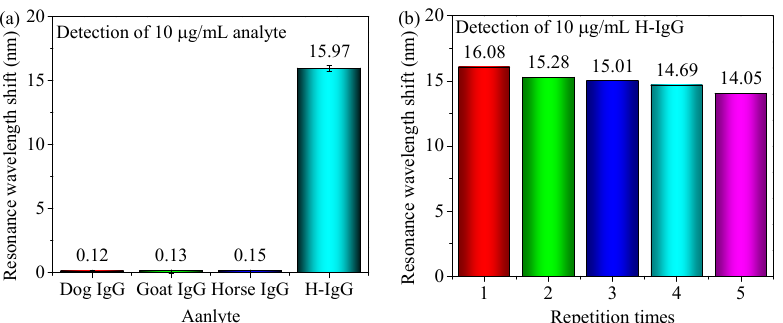
Figure 8. The ( a ) specificity and ( b ) repeatability of the sensor. Error bar = ± S.D., and the same assay in the same experimental conditions is repeated three times.